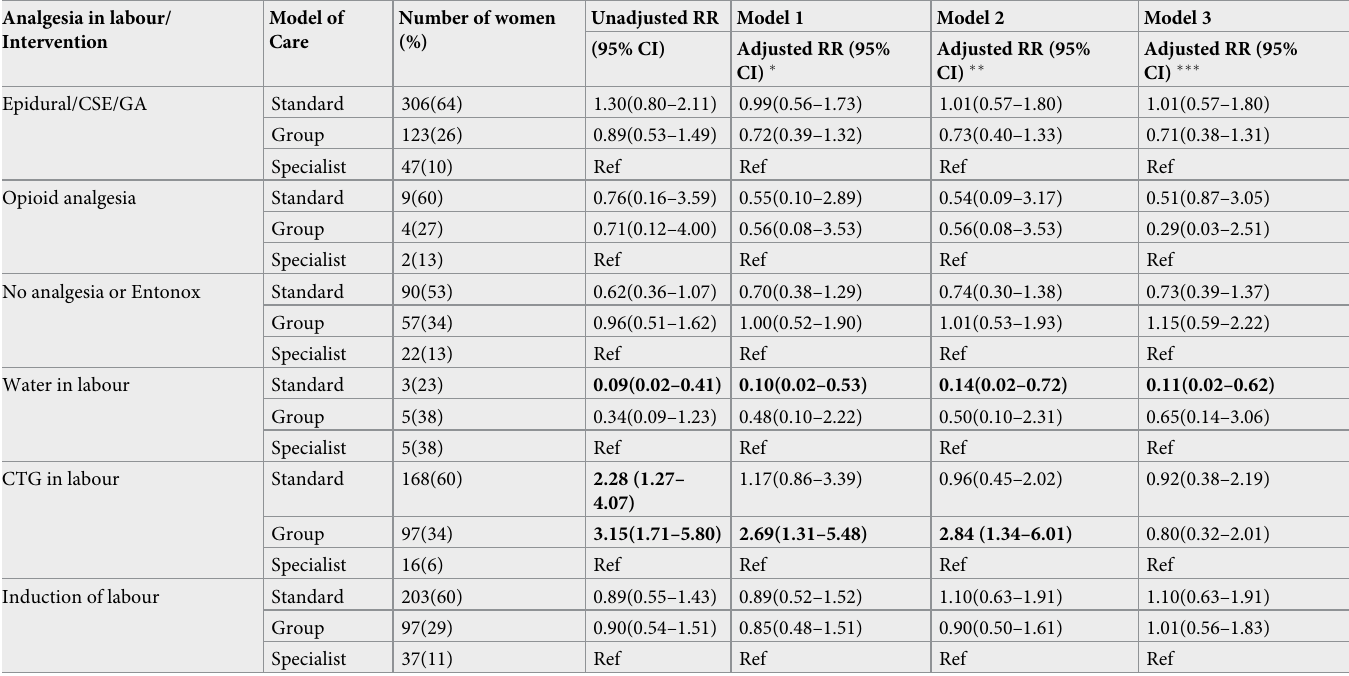
Table 6. Use of analgesia in labour and obstetric interventions in relation to the model of care received.